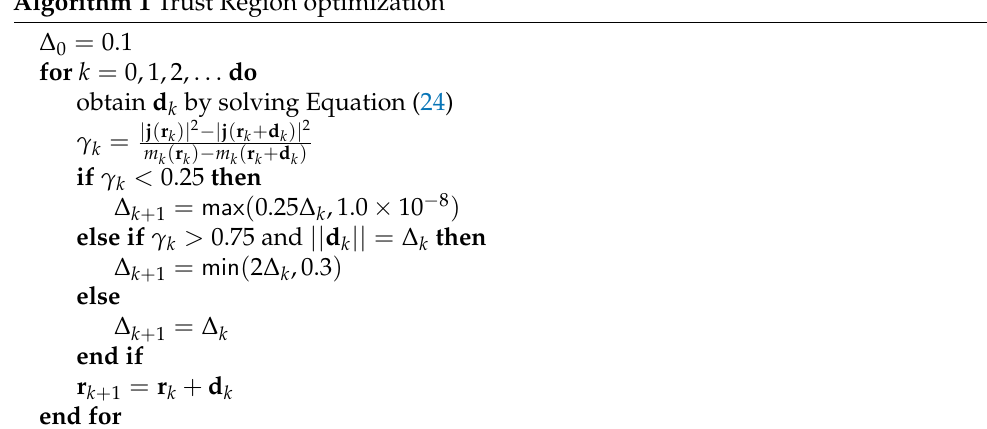
Algorithm 1 Trust Region